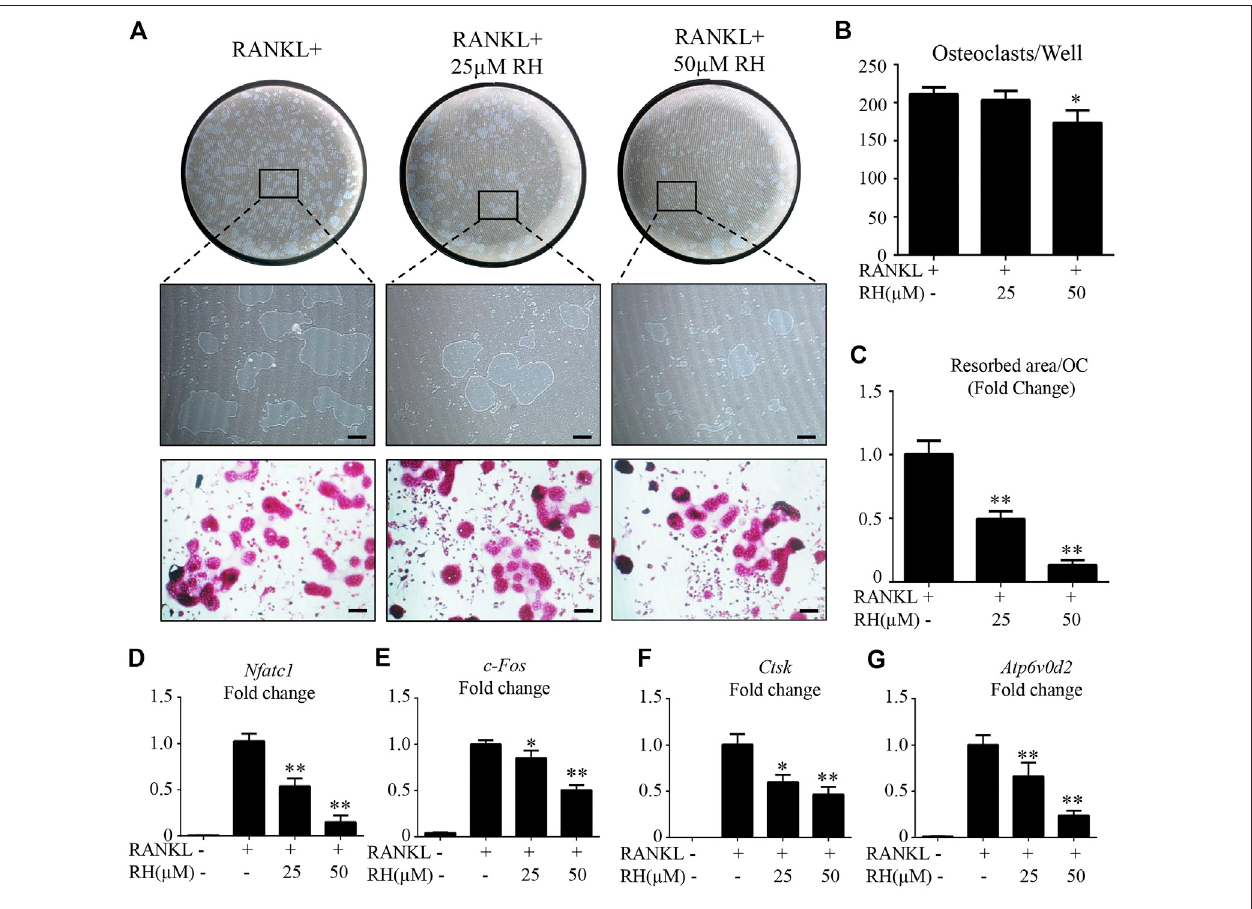
FIGURE 3 | RH attenuated osteoclast hydroxyapatite resorption and osteoclast-speci fi c genes expression. (A) Representative images of the resorption on hydroxyapatite-coated plates and TRAcP staining after treatment of RH for 48 hr. (B) Quanti fi cation of TRAcP-positive osteoclasts numbers per well ( n (cid:2) 3). (C) Quanti fi cation of resorption area on hydroxyapatite surface per osteoclast ( n (cid:2) 3). (D – G) PCR results of osteoclast-speci fi c genes Nfatc1 , c - Fos , Ctsk , and Atp6v0d2 . Gene expression levels were standardized to Hprt expression. * p < 0.05, ** p < 0.01 relative to RANKL-induced control group. Scale bar (cid:2) 200 μ m.